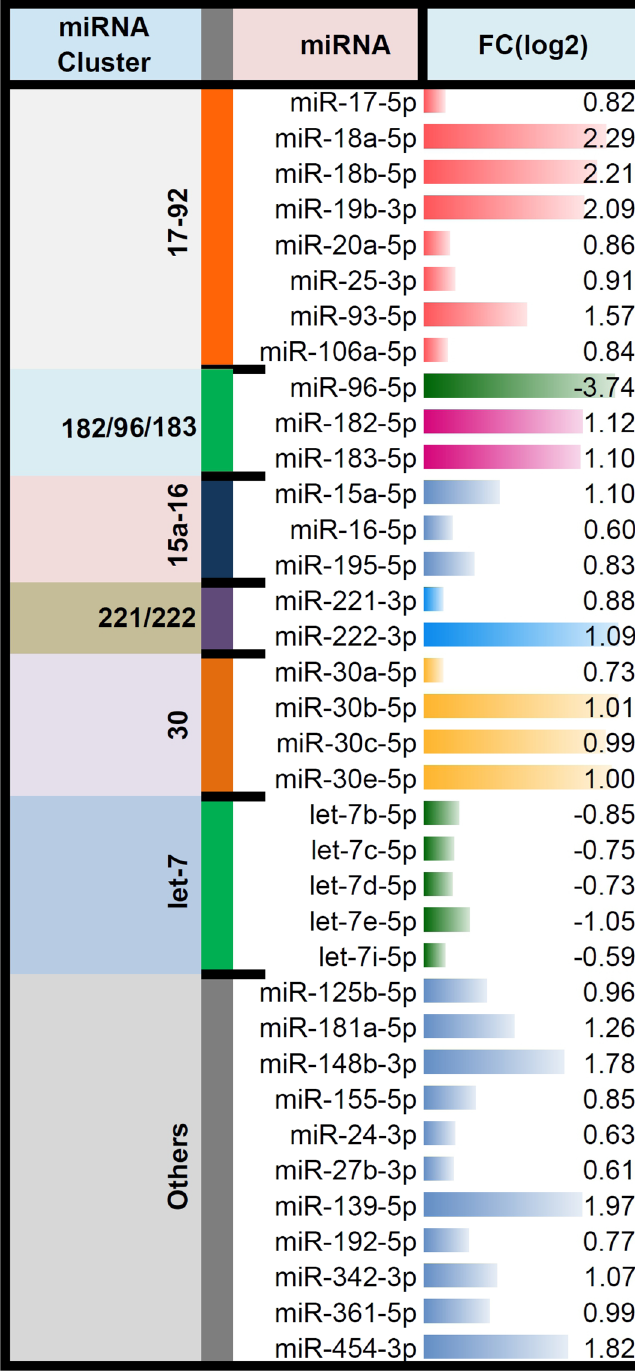
Figure 8. The miRNA clusters with their Fold Change (log2) observed in the enriched